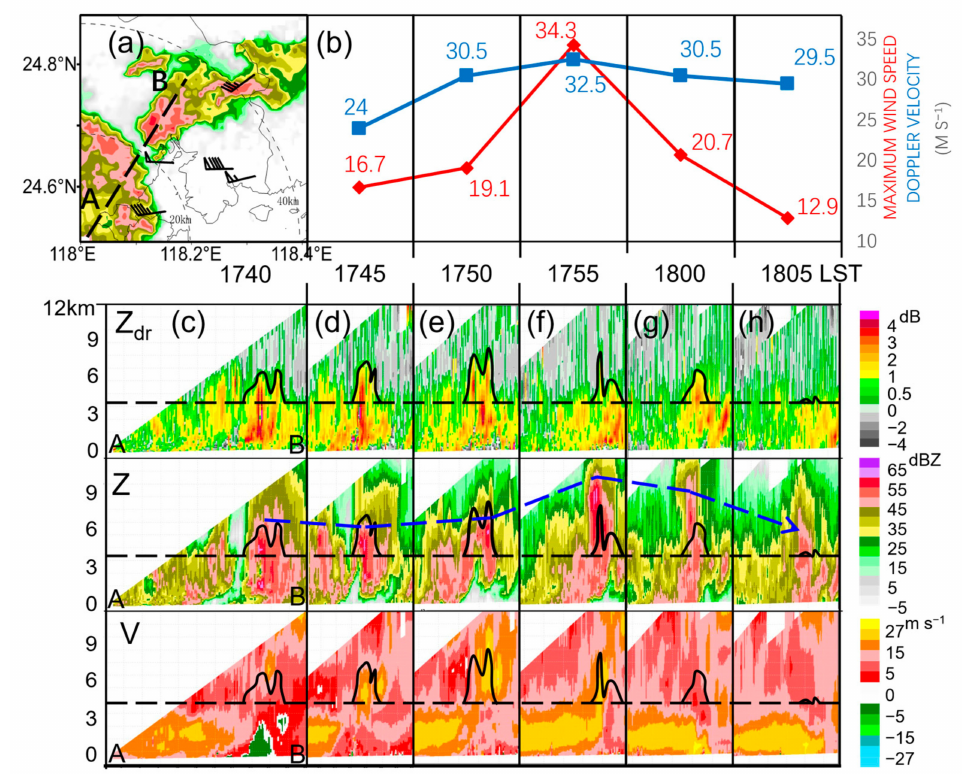
Figure 7. ( a ) The 1.5 ◦ PPI radar reflectivity distribution of the mini-supercell and the bow echo, the wind barbs (the magnitudes of the short barb, the long barb, and the flag are 2, 4, and 20 m s − 1 ) mark the locations of the maximum wind speed observed every 5 min (17:45 LST to 18:05 LST from left to right). ( b ) The observed extreme gust wind speed nearby (red line; unit: m s − 1 ) and the maximum horizontal distribution of the Doppler velocity (blue line; unit: m s − 1 ). ( c – h ) The vertical structure evolutions of differential reflectivity (Z DR ; shaded; unit: dB) (upper panels), Z (shaded; unit: dBZ) (middle panels), and V (shaded, the mean Doppler velocity and the direction from A to B is positive (southwesterly); unit: m s − 1 ) (bottom panels) from 17:40 LST to 18:05 LST. The cross-sections in ( c – h ) are along lines A–B in Figure 7a. In Figure 7c–h, the black dashed line marks the 0 ◦ C level, the top of the Z of ≥ 50 dBZ is shown by a blue dashed line, and the vertical leading edge of Z DR of ≥ 1 dB is shown by a black